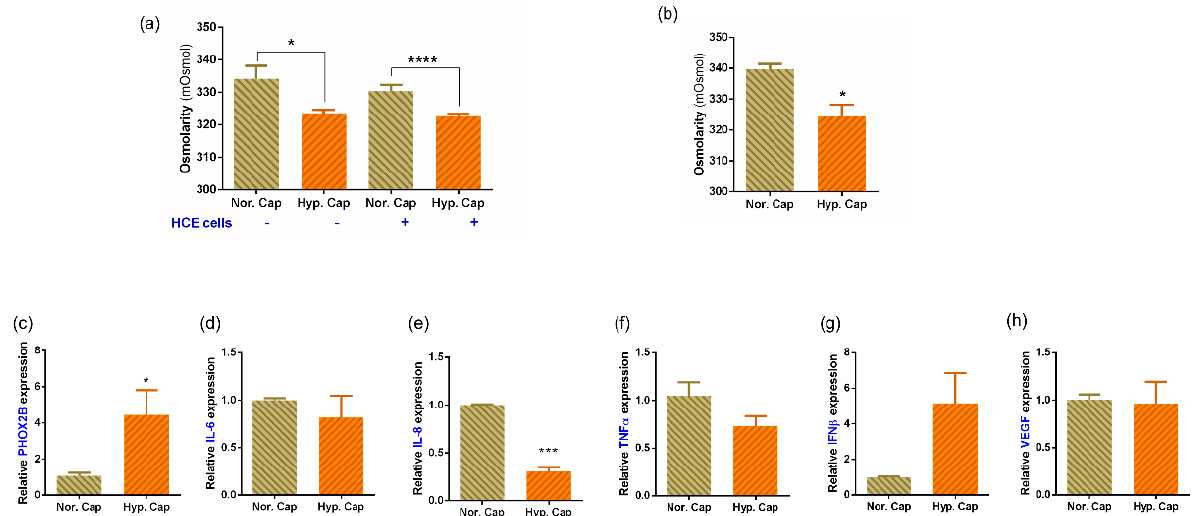
Figure 5. Effect of hypercapnia on osmolarity and expression of genes in human corneal epithelial monolayer culture and corneoscleral rim explant cultures. ( a ) Bar graph represents the osmolarity changes in culture media with and without SV40 immortalised human corneal epithelial cells (HCE2) following exposure to either 5% CO 2 (normocapnia—Nor. Cap) or 20% CO 2 (hypercapnia—Hyp. Cap), in vitro for a period of 24 h. Bar graph represents mean ± SEM of six biological replicates. * p < 0.05, **** p < 0.0001; two-tailed unpaired t -test. ( b ) Bar graph represents the osmolarity changes in culture media that contained corneoscleral rims following exposure to either 5% CO 2 (normocapnia—Nor. Cap) or 20% CO 2 (hypercapnia—Hyp. Cap), in vitro for a period of 24 h. Bar graph represents mean ± SEM from three matched biological replicates or corneoscleral rims. * p < 0.05, two-tailed paired sample t -test. ( c – h ) Graphs indicate relative mRNA expression of PHOX2B, IL-6, IL-8, TNF α , IFN β and VEGF in matched corneoscleral rims following exposure to either 5% CO 2 (normocapnia—Nor. Cap) or 20% CO 2 (hypercapnia—Hyp. Cap), in vitro for a period of 24 h. The expression of PHOX2B, IL-6, IL-8, TNF α , IFN β and VEGF was normalised to the expression of β -actin (house- keeping gene). Bar graph indicates mean ± SEM from two technical replicates for each of the three biological replicate experiments. * p < 0.05, *** p < 0.001; two-tailed paired sample t -test. PHOX2B—paired-like homeobox